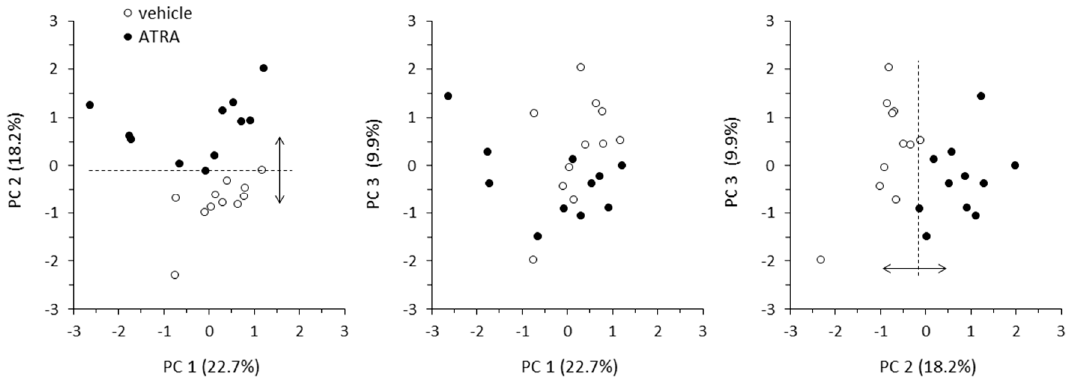
Figure 5. Score biplot representation of the first three principal components (PCs) in Principal Component Analysis. Data (of 11 animals per group) were spread by treatment to assess possible relationships between 117 variables (shown in Supplementary Table 1).